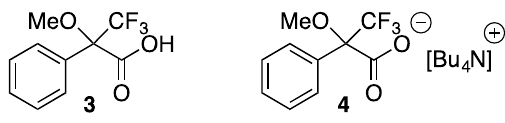
Figure 2. Mosher’s acid ( 3 ) and its n -Bu 4 N salt ( 4 ).